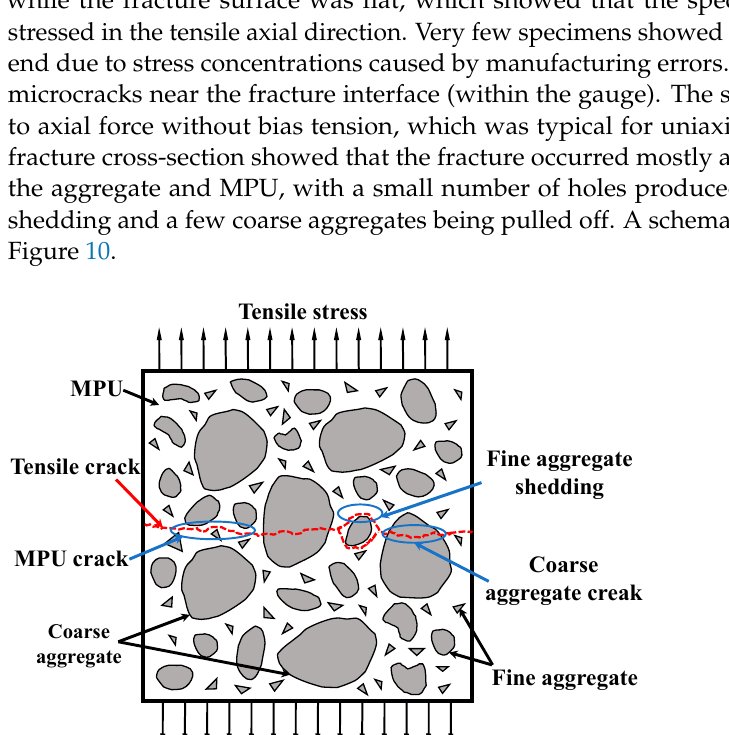
Coarse aggregate